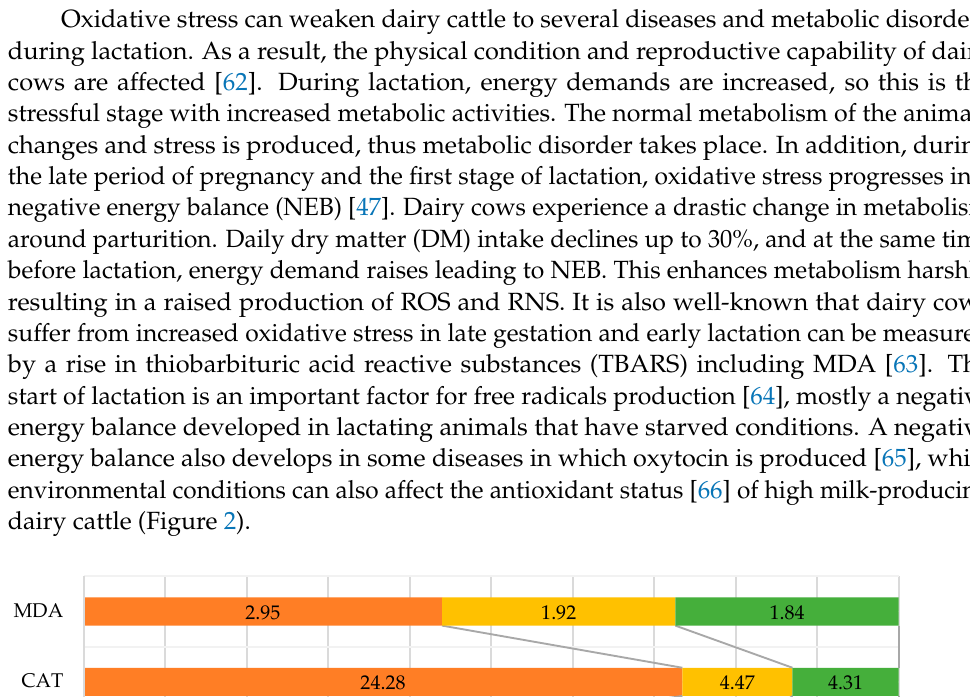
Figure 1. Oxidative stress and antioxidant status in advanced pregnant and early lactating dairy cows.